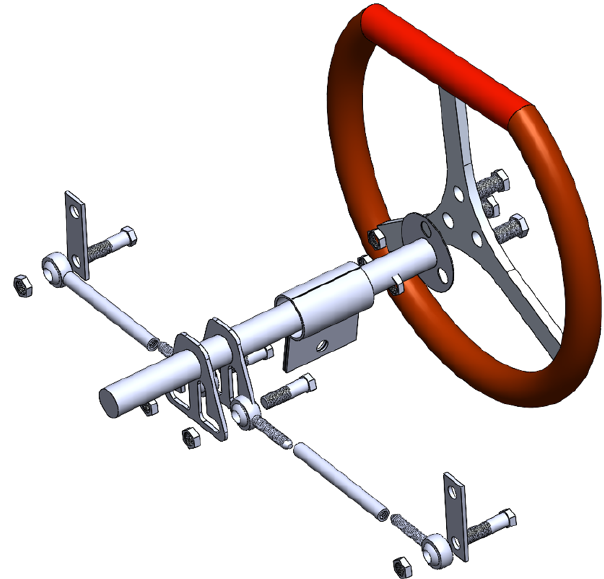
Figure 7. Exploded view of the steering